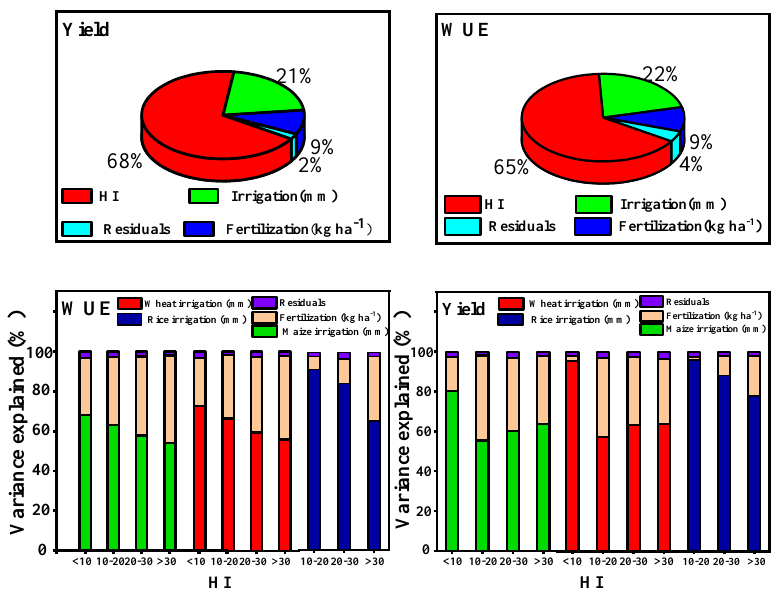
Figure 9. Significance of explanatory variables for the response of crop yield and WUE of maize, wheat and rice according to BRT (boosted regression tree) analysis.